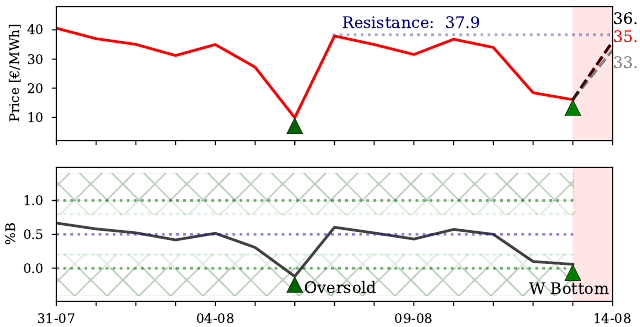
Figure A1. Single hour prediction of the 14/08/17 08h price, generated using an HR model, demonstrating the added explanatory power offered by TIs. The red line in the top graph shows raw prices, while the black line in the bottom graph shows the %B ( n = 26). Arrows and horizontal lines mark the identifiers of a W-Bottom pattern that foreshadows a strong price move towards the resistance line. The dashed lines, appearing in the red band, correspond to the benchmark forecast (grey: 33.1 € /MWh), TI forecast (black: 36.1 € /MWh), and price target (red: 35.9 €